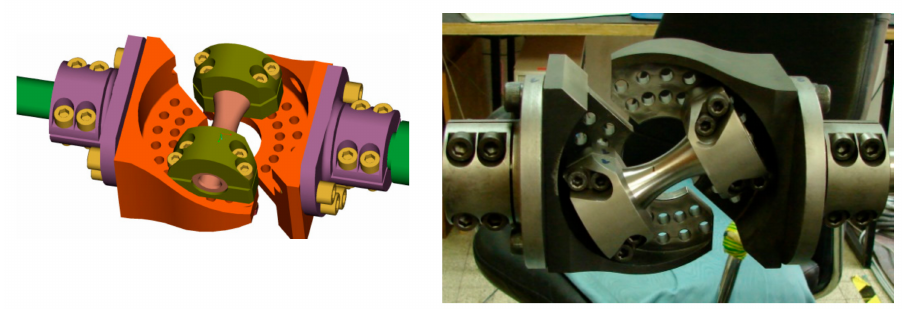
Figure 3. Setup of the experiments for load cases of torsion and bending on the torque controlled FF044 (right) and bending load case FF040 (left), both using S2 specimens. Table 3. Summary of all load cases. Abbreviations used: Ten—tension, To—torsion, RP—pressurized, PV—pressure